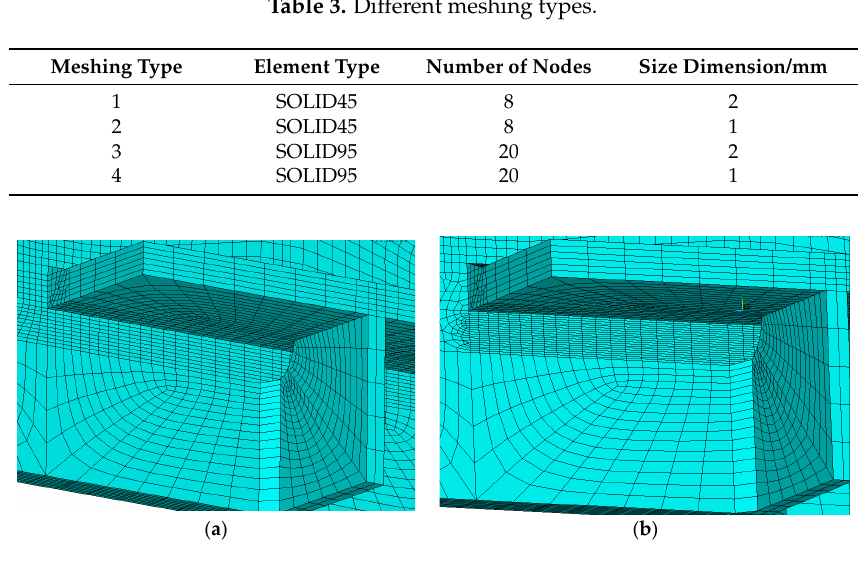
Appl. Sci. 2017 , 7 , 71 Figure 10. Different meshing style: ( a ) size dimension is 2 mm; and ( b ) size dimension is 1 mm.